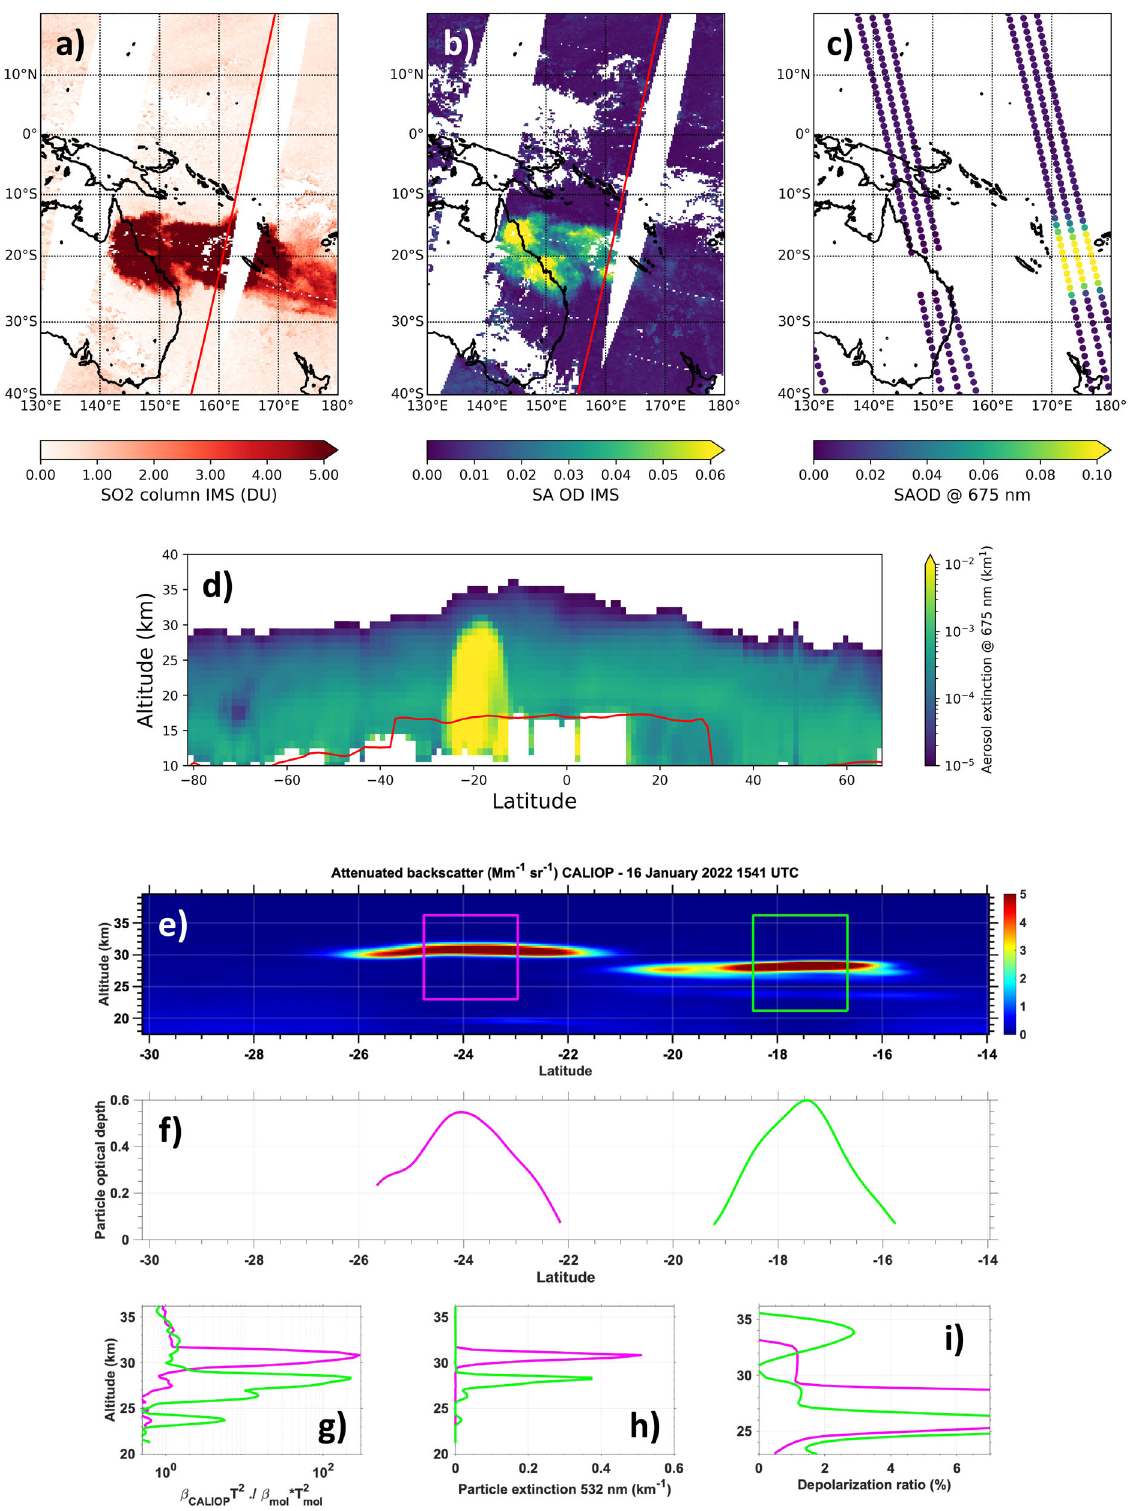
Fig. 2 The physicochemical properties of the early HT plume. IMS/IASI SO 2 ( a ) and sulfate-speci fi c AOD ( b ) observations for 16th January at 23:07 UTC. a , b the red line is CALIOP track for the same day at 15:41 UTC. OMPS-LP integrated SAOD ( c ) and vertical aerosol extinction pro fi le (central detector, d ) for 16th January at 2:03 and 3:27 UTC. d the red line is tropopause height. Attenuated CALIOP backscatter at 532 nm ( e ), and integrated in-plume AOD ( f ), corrected transmission ( g ) extinction ( h ) and depolarisation ( i ) in the two identi fi ed plumes sections (pink and green squares). The CALIOP track of e – i is the one identi fi ed in a and b . Due to the time mismatch between CALIOP and IASI orbits, the CALIOP trace actually crossed both the eastern part of the aerosol plume in a , b (lower plume at 27 km) and the western part (upper plume at 30 km) which has already reached Australia in the display.